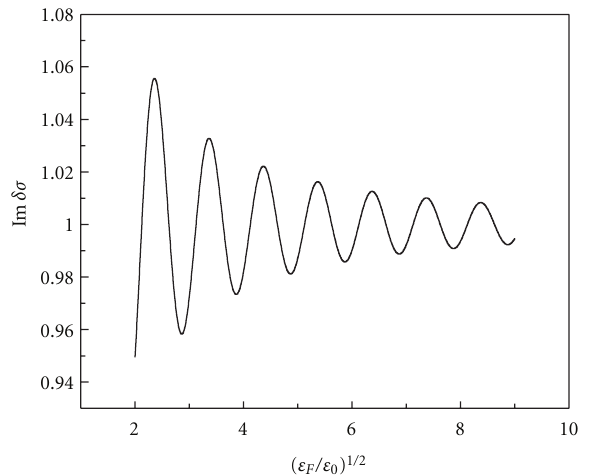
Figure 3: Dependence of the first harmonicIm δσ (23) on ( ε F /ε 0 ) 1 / 2 under Φ / Φ 0 = 0 .